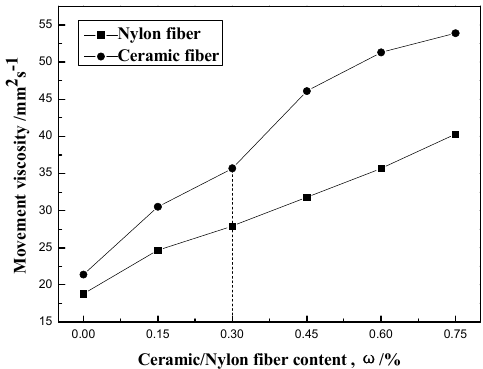
Figure 3. Influence of fiber content on the movement viscosity of composite silica sol slurry.